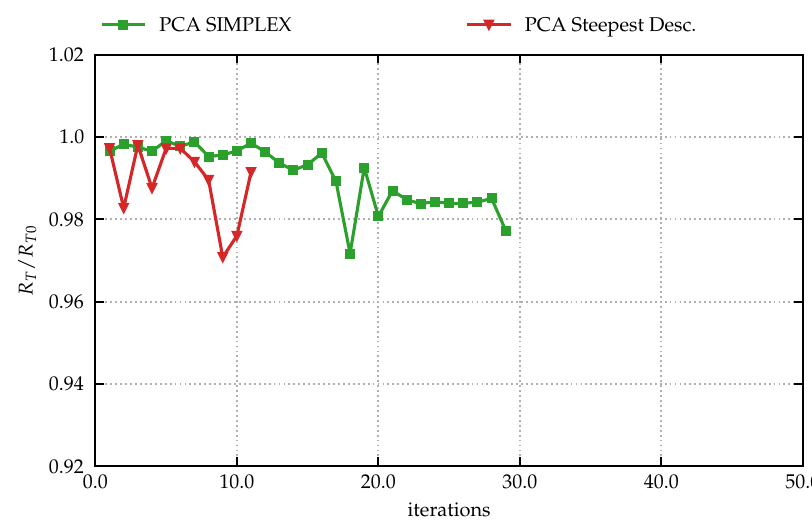
Figure 21. Evaluation of objective function with Neptuno for both optimisation algorithms us- ing PCA.